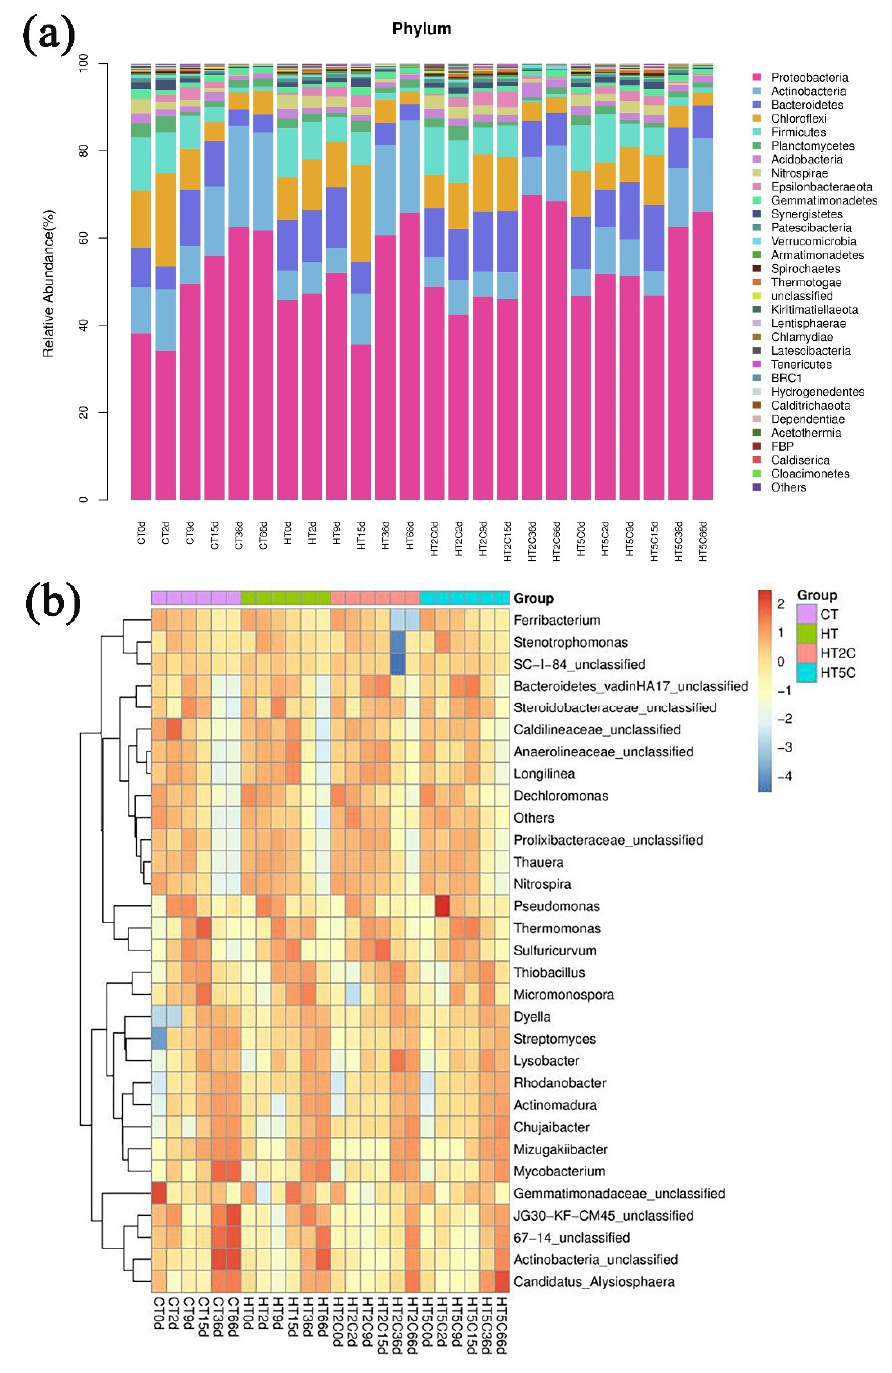
Figure 3. ( a ) Relative abundances of dominant phyla during composting. ( b ) The relative abundances of different bacterial genera in the different composting treatments.